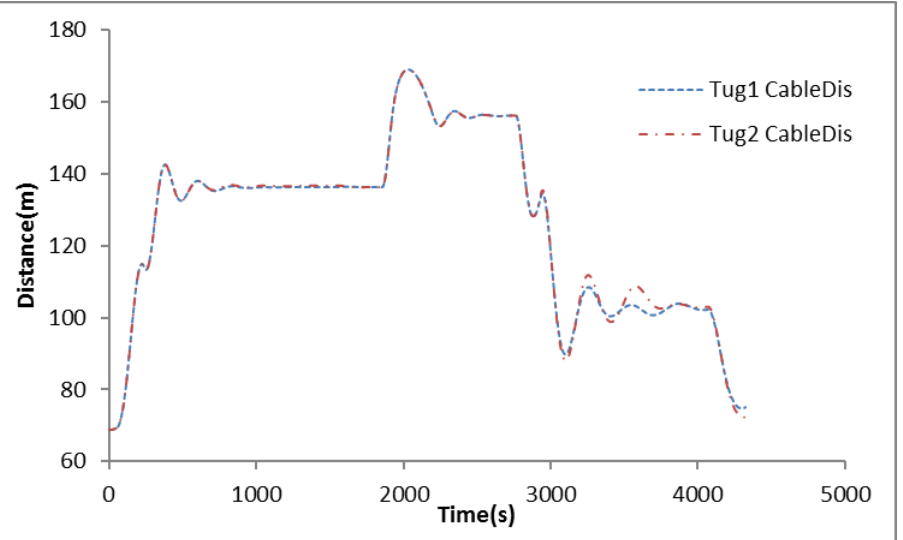
Figure 20. The change of rope length during the towing process.